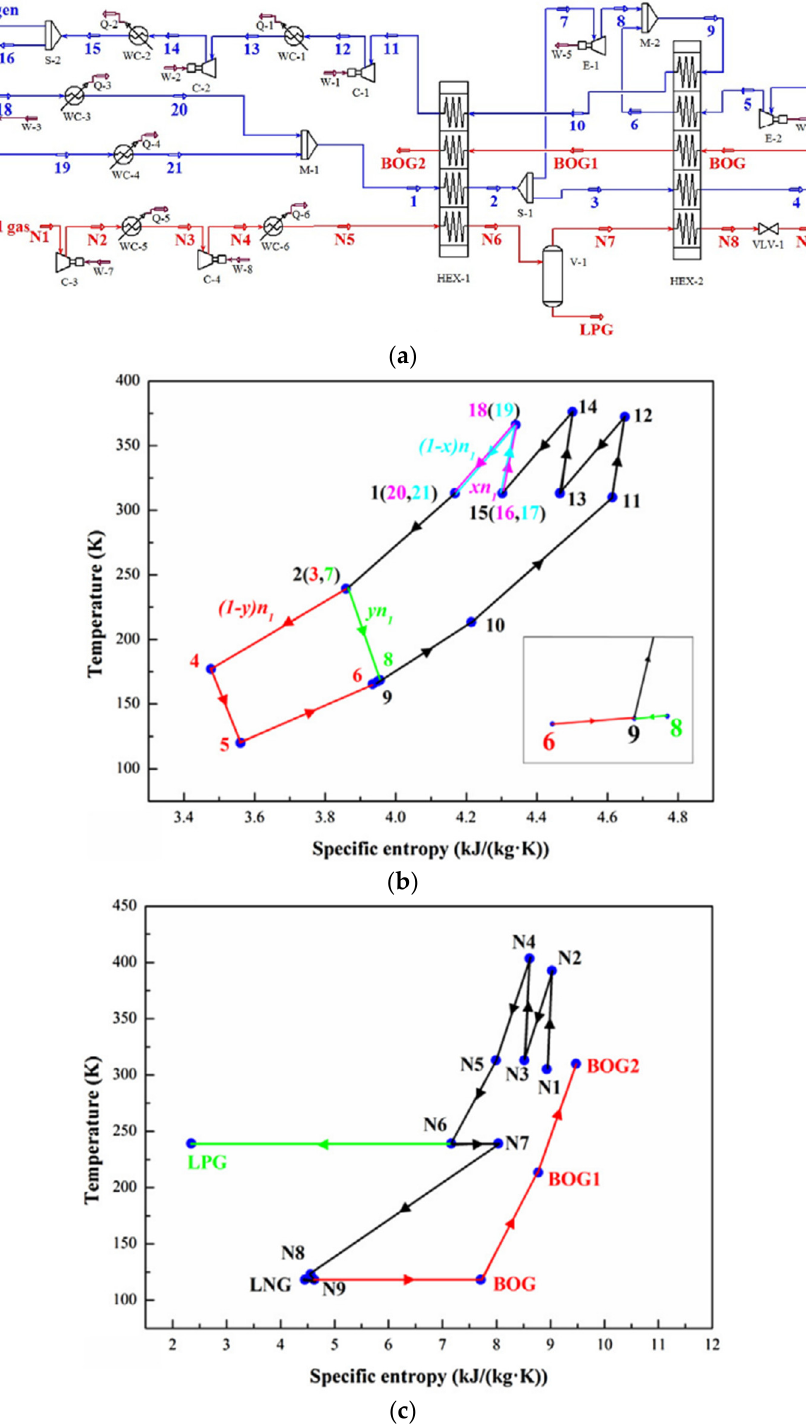
Reproduced with permission from Elsevier (license number 5413370329012). Figure 18. ( a ) The diagram of the parallel nitrogen expansion liquefaction process (PNEC); ( b ) Temperature-Entropy diagram of parallel nitrogen expansion liquefaction process; ( c ) Temperature-Entropy diagram of natural gas [61].